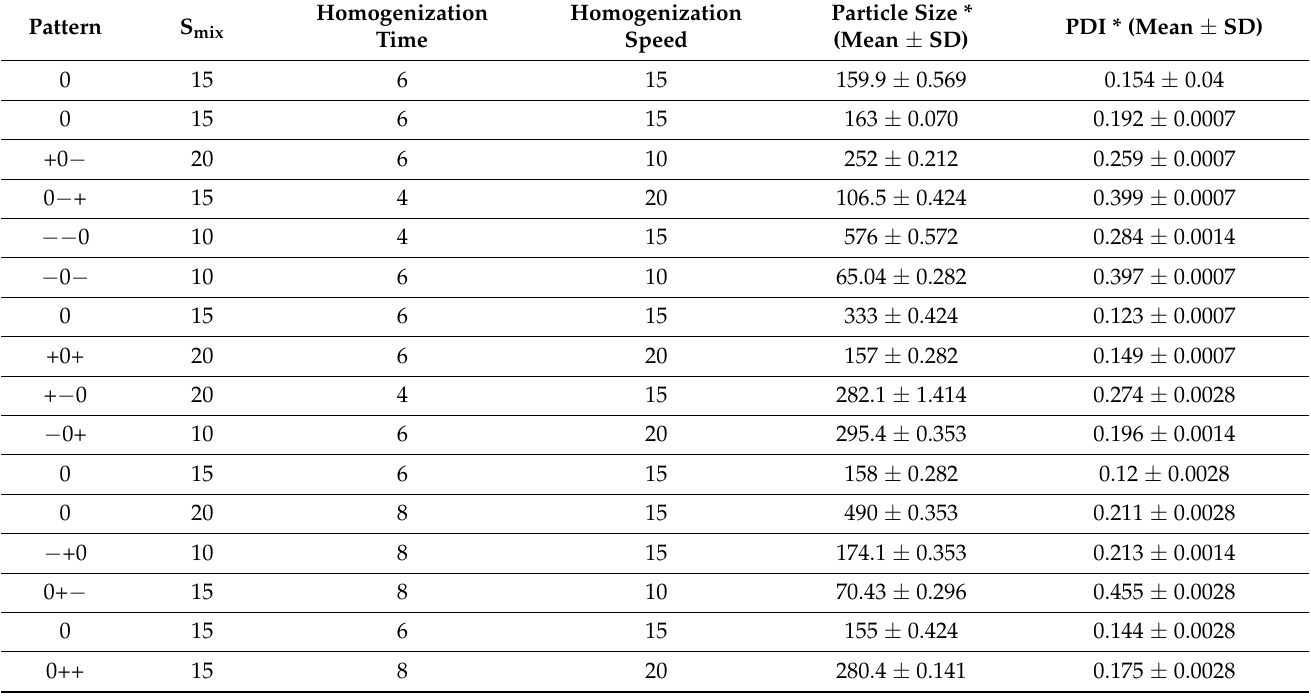
Table 2. Box Behnken design factors and observed responses for MeHCl and TMPS loaded SLNs (* Mean ± SD, n =